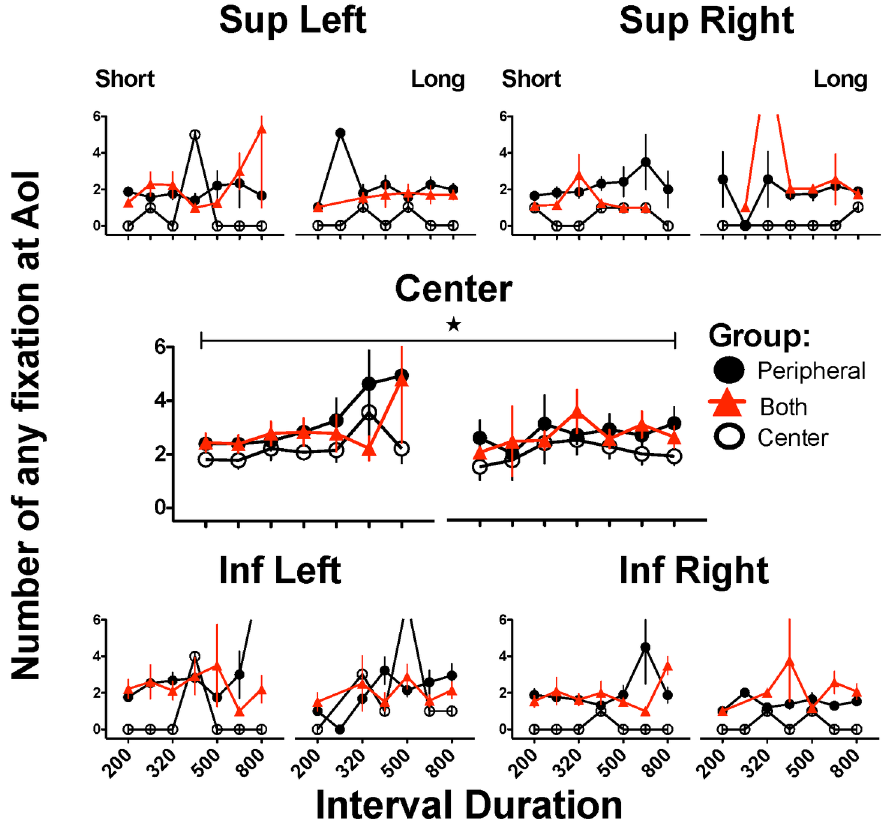
Fig 6. All fixations to each Area of Interest during generalization trials. Number of any fixation (includes fixations even if duration and latency criteria were not meet) to each Area of Interest (AoI) where a stimulus could appear. For each AoI, left panels present the performance on trials where subjects categorized intervals as “ short ” and right panels correspond to categorizations as “ long ” ; only intervals close to or at the extreme durations present mean of 15 subjects since some subjects never emitted erroneous categorizations. Stars and horizontal bars indicate significant differences between denoted groups after two- way ANOVA followed by Bonferroni´s test (p < 0.05) (see text); only data from anchor intervals with N = 15 were included in statistical